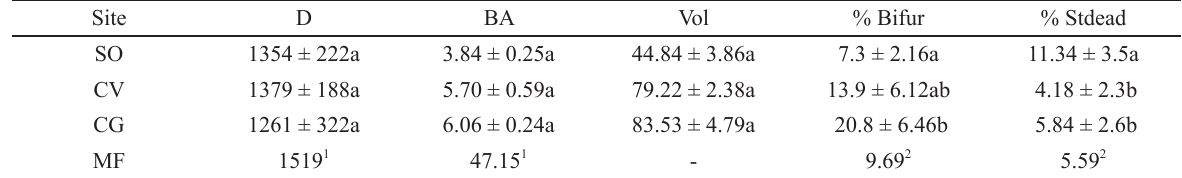
Structural parameters of the tree communities analyzed in the three forest fragments Sooretama (SO, 14 years after fire), Córrego do Veado (CV, 25 years after fire), Córrego Grande (CG, 25 years after fire) and in a mature forest (MF), State of Espírito Santo, Brazil. D = density/ha, BA = basal area (m 2 /ha), Vol = volume (m 3 /ha), %Bifur = percent of bifurcated individuals and % Stdead = percent of standing dead individuals. The values in the same column followed by different letters are statistically different (p≤